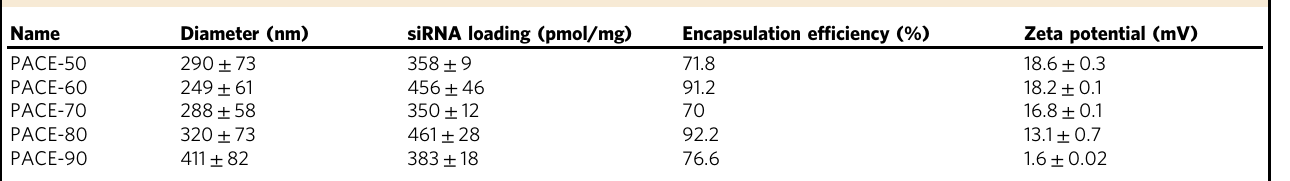
Table 2 Characterization of PACE